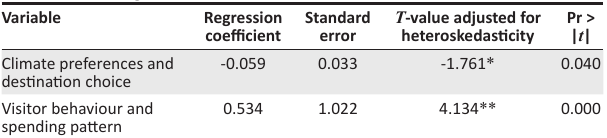
TABLE 3: Panel regression